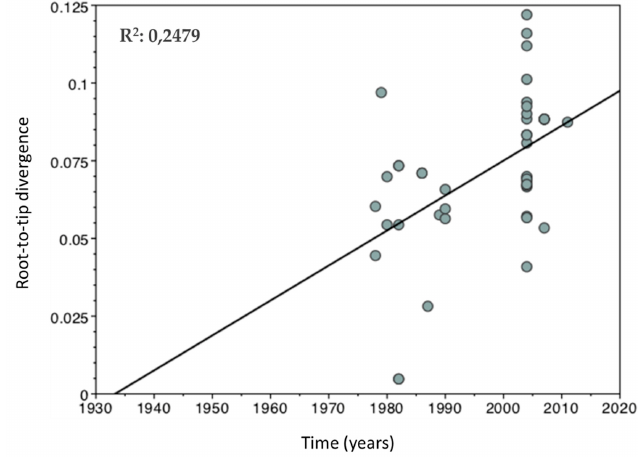
Figure 1. Temporal signal linear regression graph. The graph shows the positive correlation between genetic diversity from root ‐ to ‐ tip ( y ‐ axis) and time ( x ‐ axis). This effect on the relationship of these variables shows the existence of a temporal signal in the data set that makes it sufficient to perform molecular clock analysis. Evolutionary dynamics analysis being performed in isolated sequences from different regions of South America showed the most recent common ancestor time, dating to 47 years prior to the most recent sample, estimated in 1964 according to the mean of the data (95% of HPD between 1952 and 1972) (Figure 2).